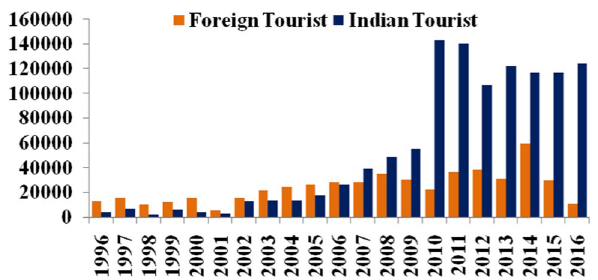
Fig. 3 Tourist load in Leh, Ladakh, India from 1996 to 2016. Source Ladakh Tourism Center, Leh, India